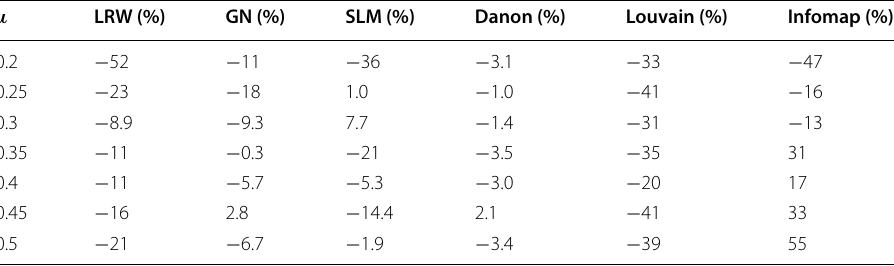
Table 7 Changes of computational time on graph clustering algorithms in percentage